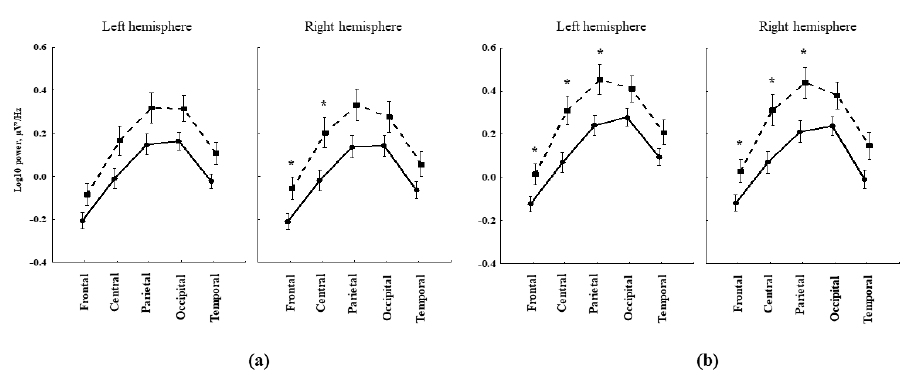
Figure 3. Lateral differences in the alpha2-rhythm power changes of EEG resting state with eyes open in patients after on-pump CABG, depending on the presence of CA stenoses less than 50%: ( a ) before cardiac surgery; ( b ) after surgery; solid lines—the patients without stenoses, dashed lines—the patients with CA stenoses, error bars denote SE, *— p < 0.05 Newman–Keuls multiple comparison